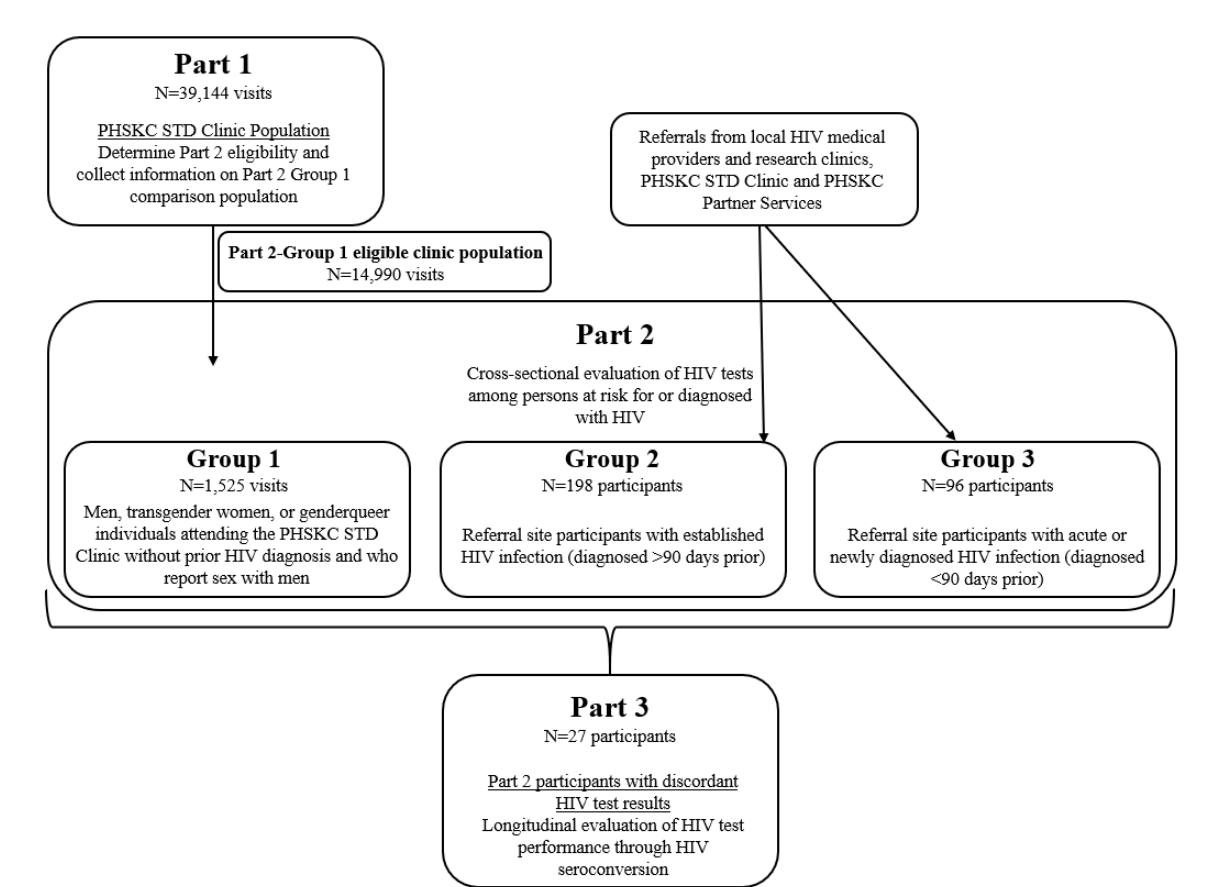
Figure 1. Project DETECT study